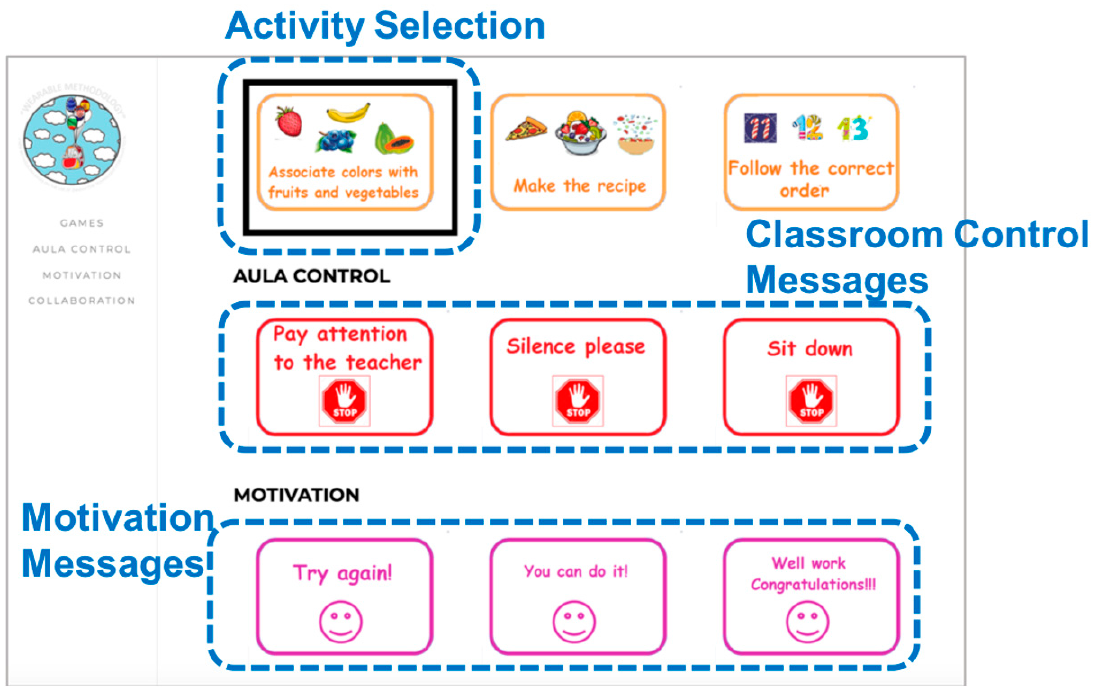
Figure 6. Teacher App